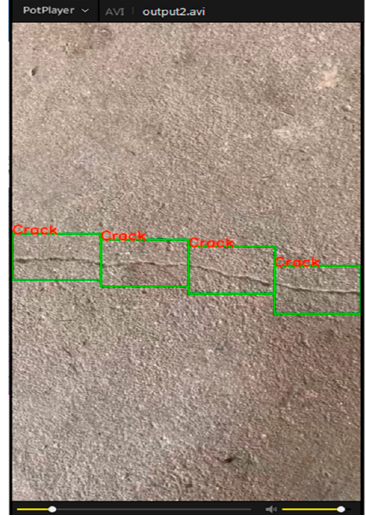
Figure 13. Video test.